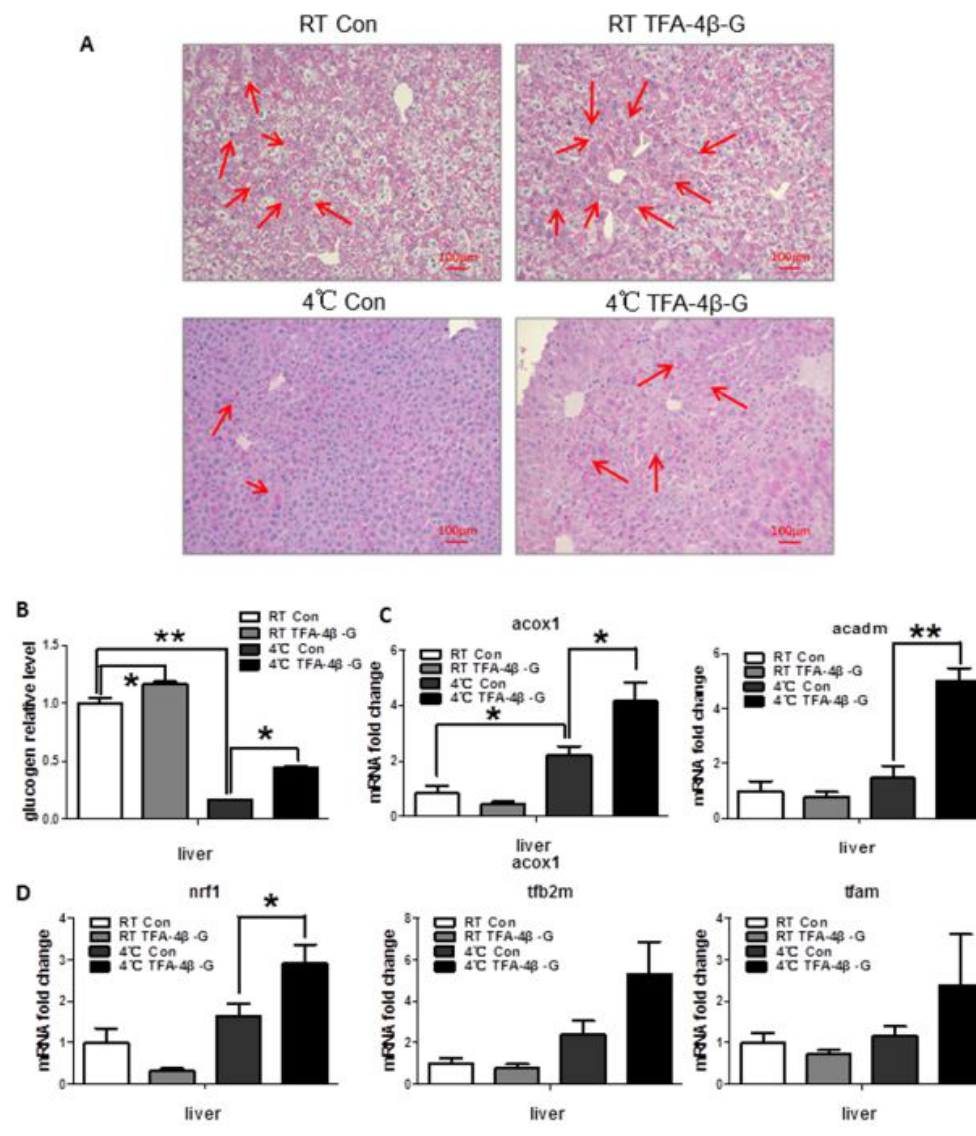
Figure 3. Trans -ferulic acid-4- β -glucoside promotes energy consumption in liver. ( A ) PAS stain in liver (red arrow indicated the glycogen); ( B ) relative glycogen expression in liver; ( C ) mRNA expression related to lipometabolism in liver ( n = 4); ( D ) mRNA expression related to mitochondrial biogenesis in liver ( n = 4). * p < 0.05, and ** p < 0.01 as indicated.